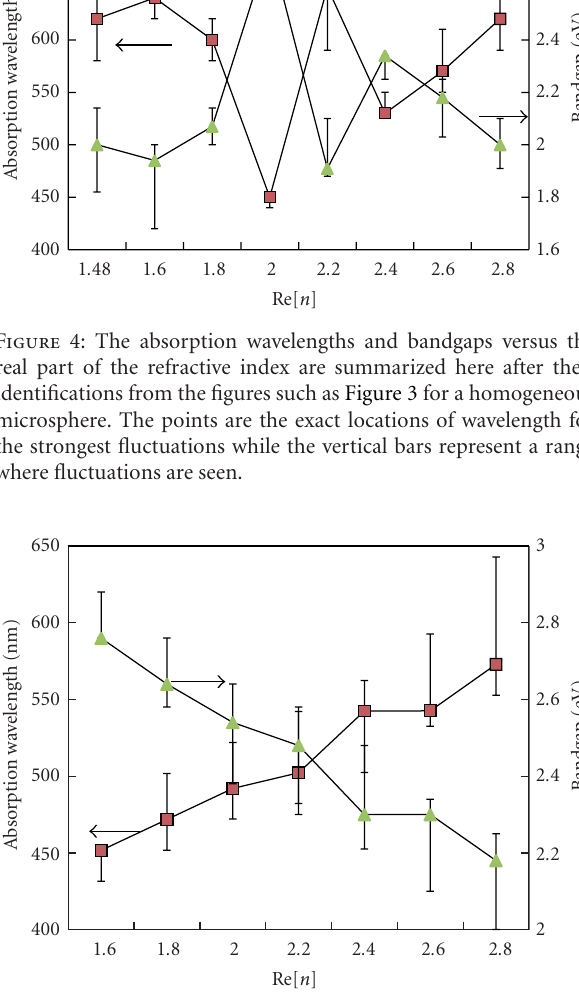
Figure 5: The absorption wavelengths and bandgaps versus the real part of the refractive index are summarized here after their identifications from the figures such as Figure 3 for a core-shell microsphere. The points are the exact locations of wavelength for the strongest fluctuations while the vertical bars represent a range where fluctuations are